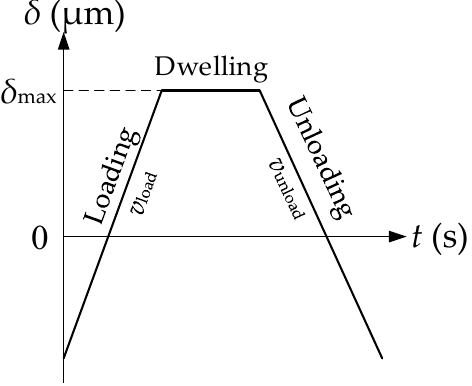
Figure 4. Loading history in the